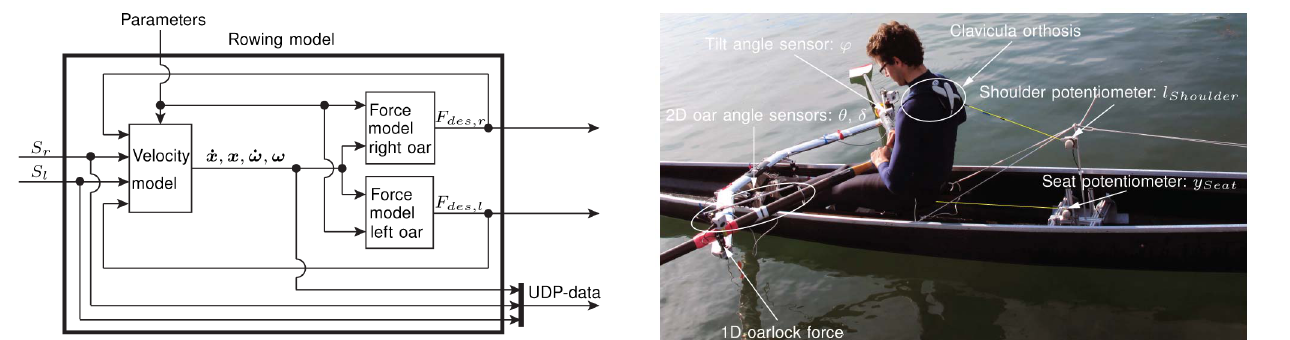
Figure 9. On-water measurement in a skiff for beginners. The skiff (Sta¨mpfli Racing Boat AG, Switzerland) was equipped with a measurement system ( BiorowTel H version 3.5). This measurement system allowed for measurement of biomechanical performance measures in a similar way as in the simulator. The person of the photograph has given written informed consent, as outlined in the PLOS consent form, to publication of his photograph.